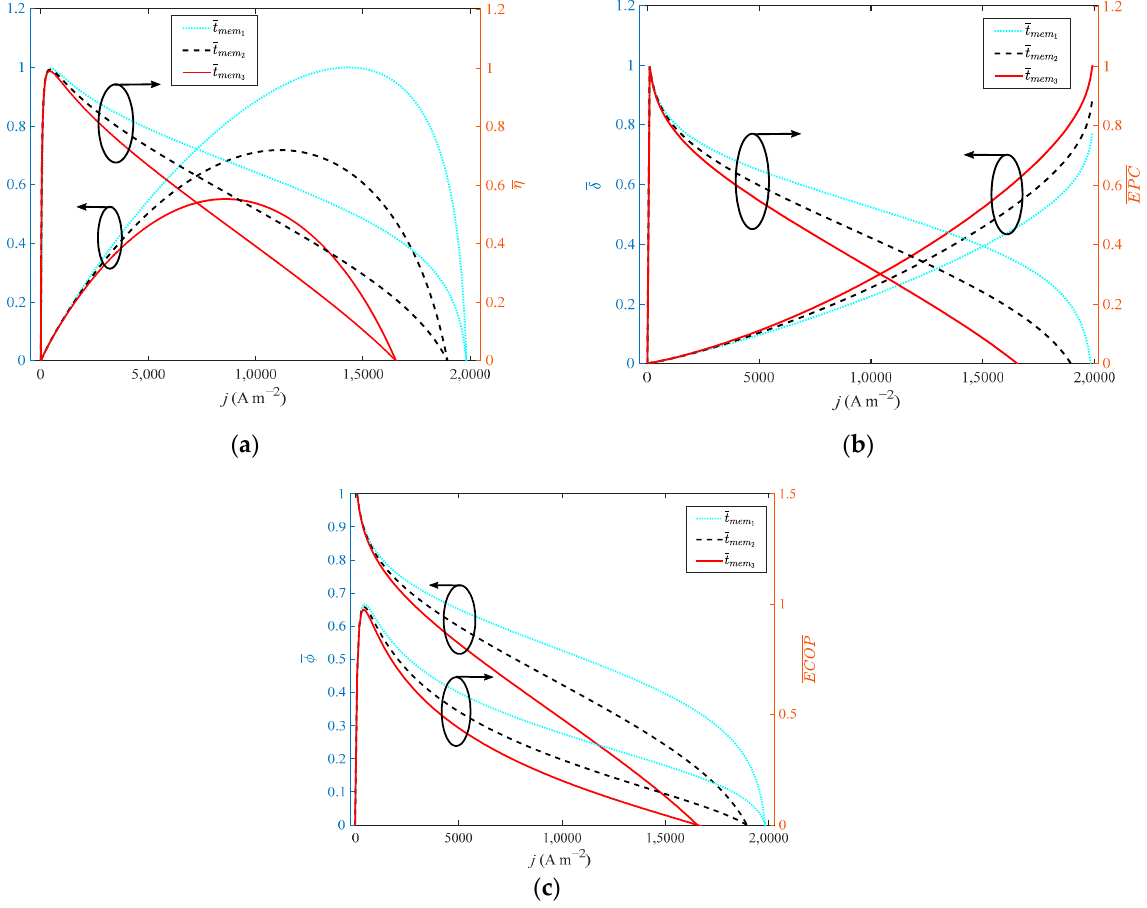
Figure 8. Different indexes vary with current density at different membrane thicknesses: ( a ) P and η ; ( b ) δ and EPC ; ( c ) φ and ECOP .